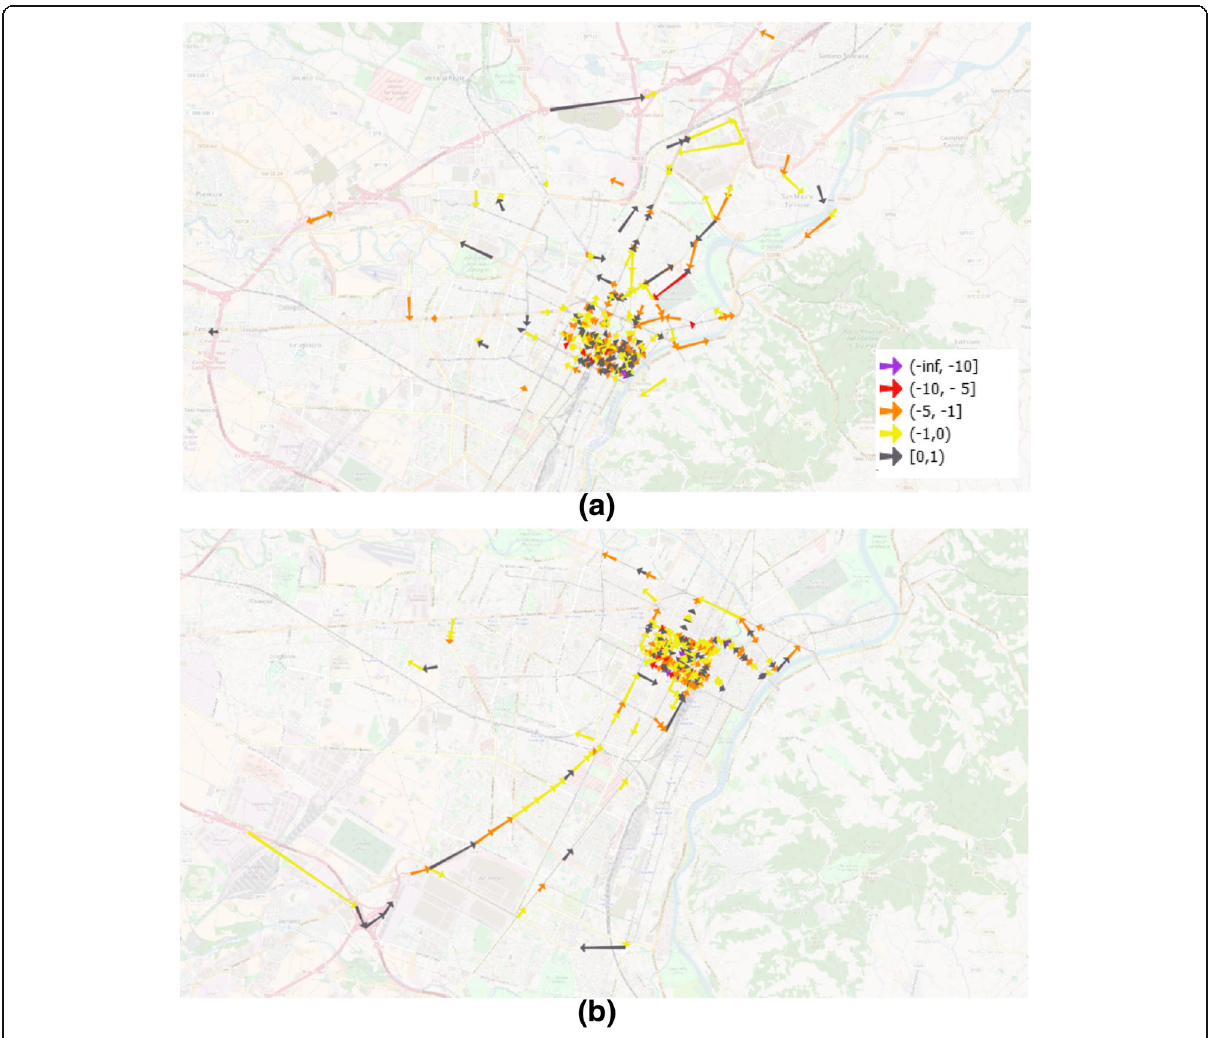
Fig. 4 Value of indicator for a selection of vehicle, namely vehicle 32 ( a ) and vehicle 16 ( b